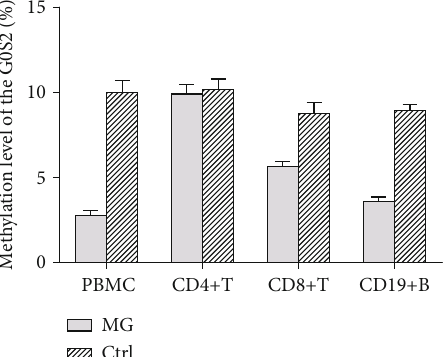
Figure 4: The correlation analysis between the expression level and methylation level of the G0S2. 95% con fi dence interval is -0.8295 to -0.3475 The y -coordinate represents rate of methylation result; each dot represents an individual expression result ofG0S2. The oblique line is the fi tting curve of methylation level of